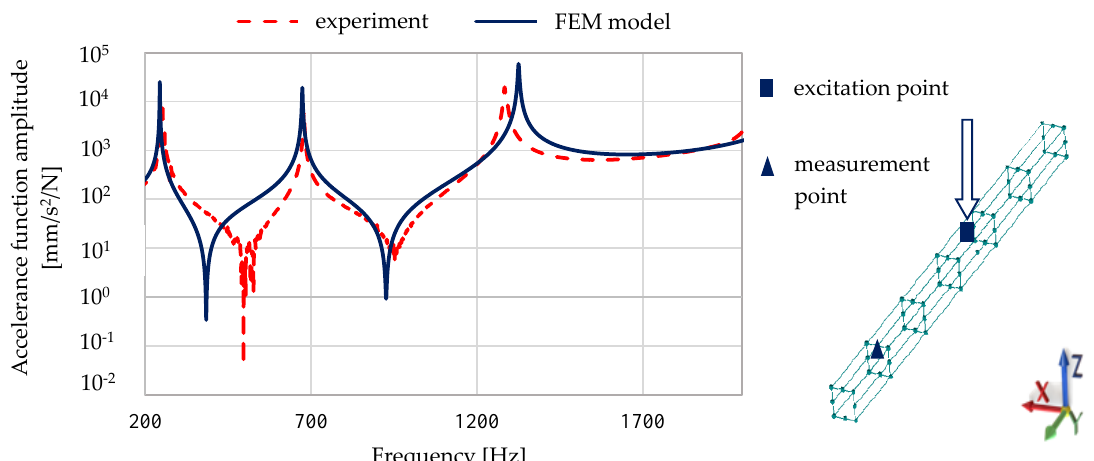
Figure 10. Comparison of calculated and experimentally determined accelerance functions for a 50 mm × 50 mm steel–polymer concrete beam.